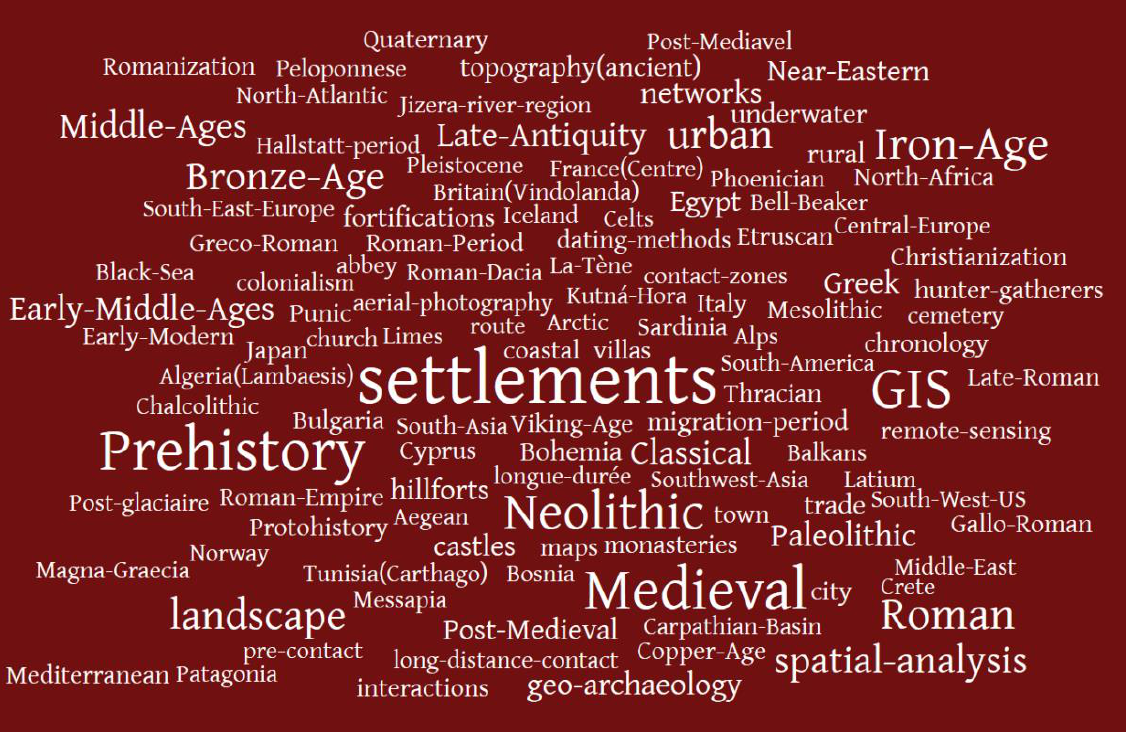
Figure 1 : Word cloud of 115 terms for cultural periods, locations, relations & processes. Cultural